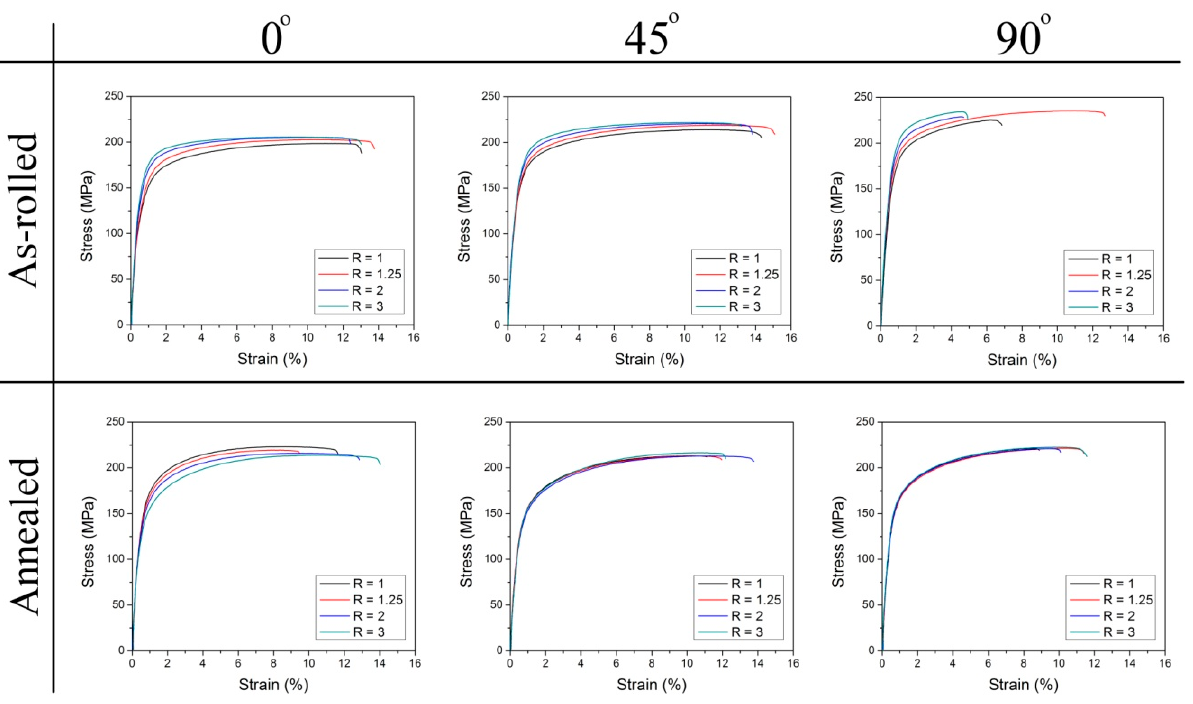
Figure 8. Stress–strain curves obtained for the as-rolled and annealed Mg-6Sn samples processed with different speed ratio (R). Table 1. Mechanical properties (YS—yield strength, UTS—ultimate tensile strength, A u —uniform elongation, A—elongation to failure, n —strain hardening exponent) of the as-rolled and annealed Mg-6Sn sheets processed with different speed ratio.